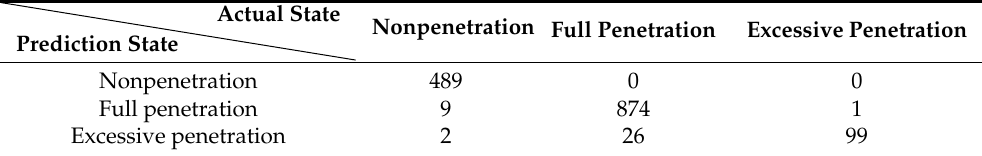
Table 5. Prediction results of each penetration state by using BP neural network.